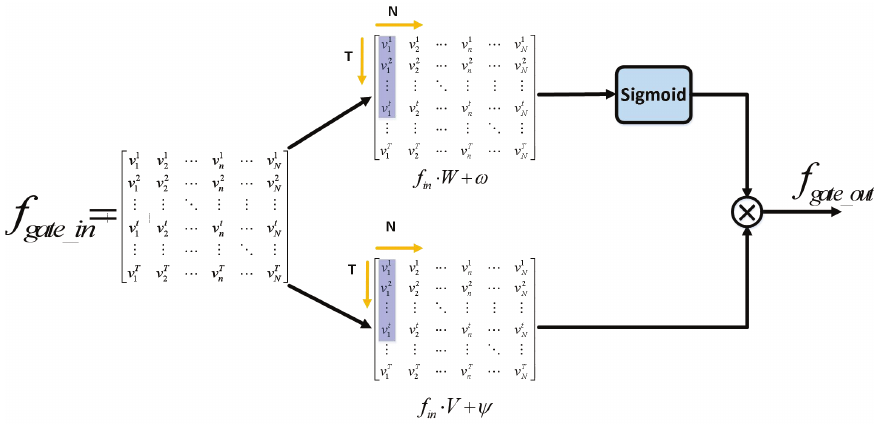
Figure 2. Temporal gated